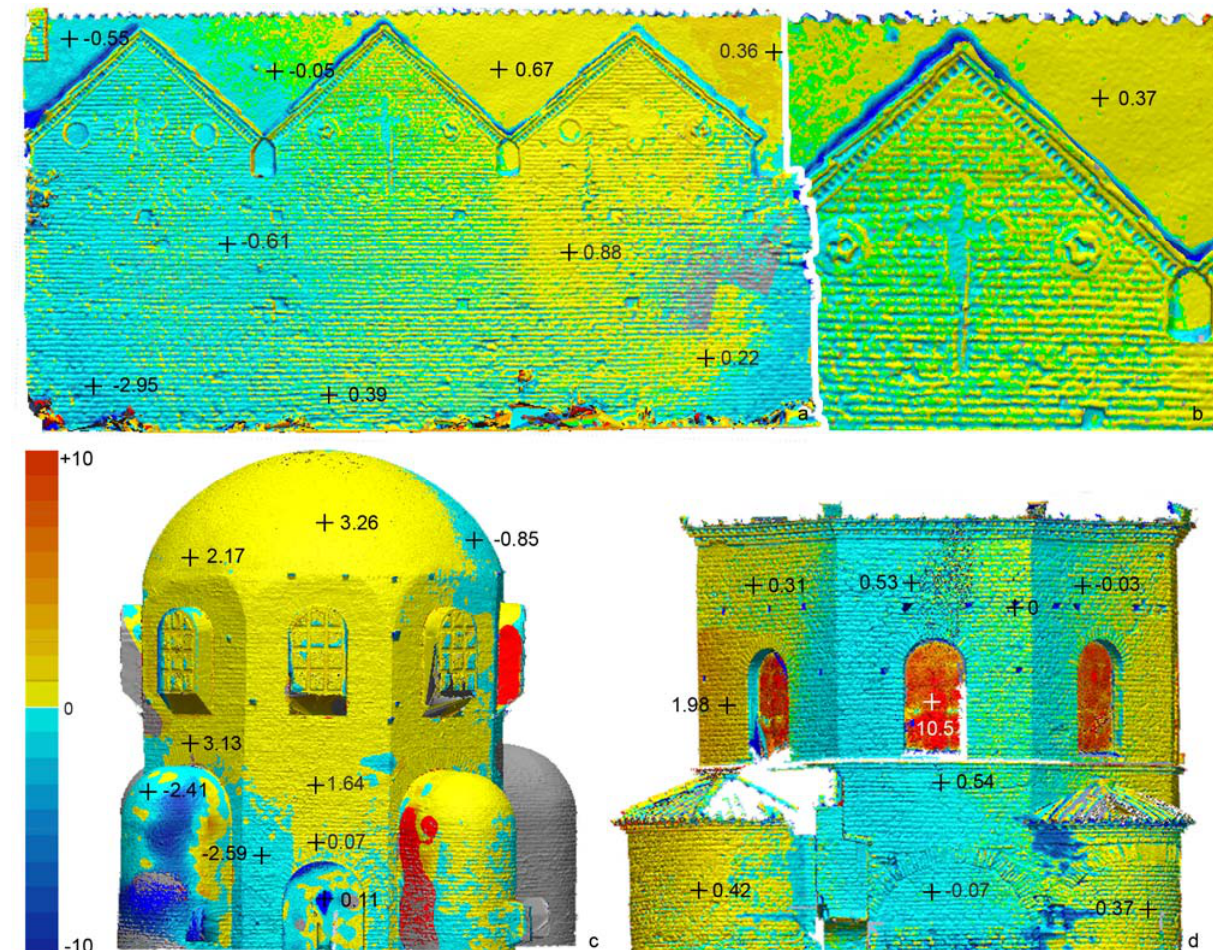
Figure 6. Deviation between meshes of the Drogdone wall (a, b), of the inner surface of the Battistero degli Ariani (c) and of its outer space (d) derived by laser scanner and by the SfM tool. Distances measured in some crucial points highlights how the geometry of bricks and mortar are detailed also when derived using the SfM approach. Red and dark blue areas show the maximum distance that is generally due to incorrect automatic filling of lacks performed by Autodesk